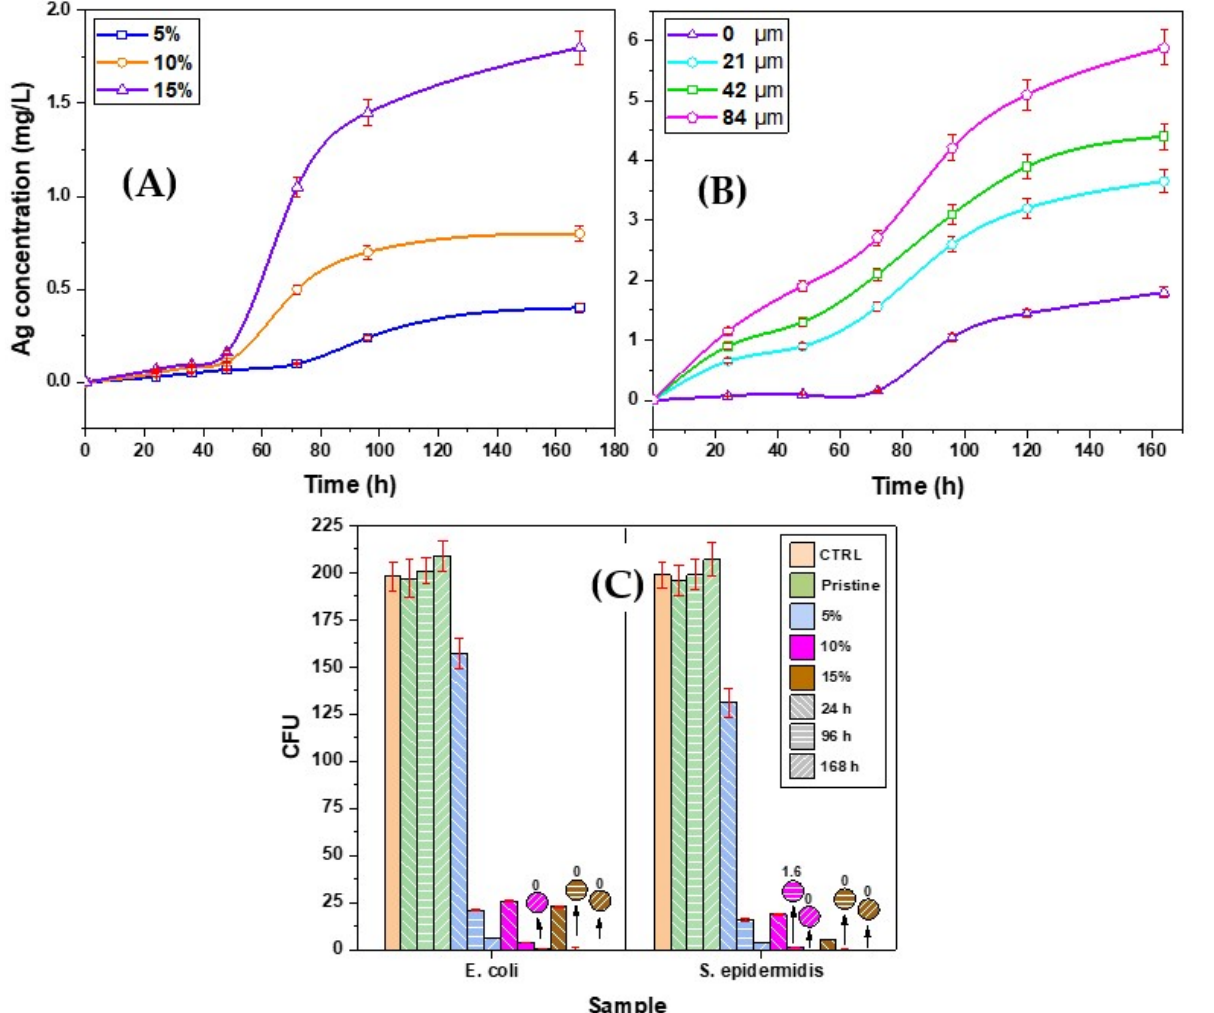
Figure 5. Concentrations of silver ions released into the water as a function of the original concentrations of Ag in solid samples and total soaking time ( A ); concentration of the Ag + released into water from samples of concentration 15% as a function of the microstructure height and the total period of soaking 0: no microstructure (flat surface), 21, 42 and 84 μ m ( B ); the number of colony-forming units (CFU) of E. coli and S. epidermidis ( C ).